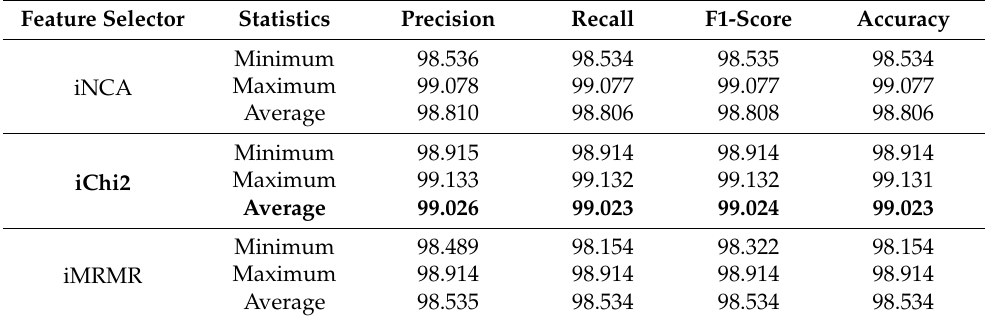
Table 5. Performance metrics for the convolutional neural network against each feature-selection technique. Feature Selector Statistics Precision